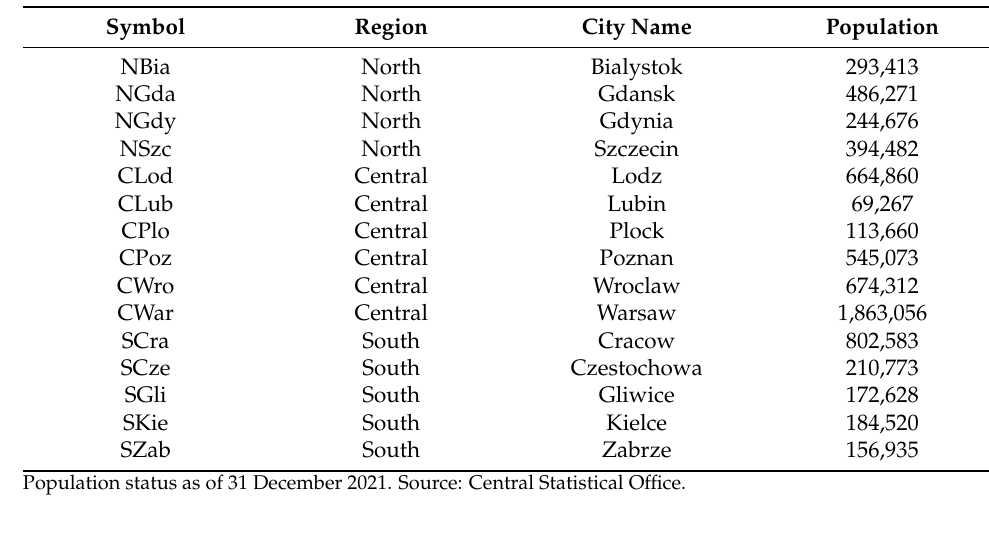
Table 1. Measuring station symbols.